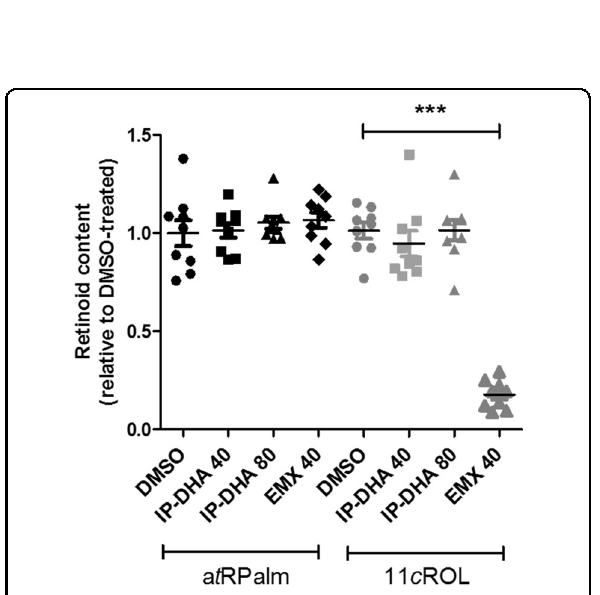
Fig. 8 Emixustat, but not IP-DHA, inhibits RPE65 isomerase activity. HEK-LR cells stably expressing LRAT-CFP and RPE65-GFP were plated in T25 fl asks at 10 5 cells/ml and grown for 24 h before DMSO (CTL), IP-DHA (40 and 80 µM), or EMX (40 µM) was added. Cells were cultured for 24 h and incubated with 10 µM a t ROL for the last 24 h. Normal-phase HPLC was used to analyze the retinoid extracts from the cells. Data are presented as the mean ± SEM. *** n = 3 independent experiments with each treatment performed in triplicate. One-way ANOVA Kruskal – Wallis test with Dunn ’ s multiple comparison test: p < 0.001 EMX vs. DMSO. Black dots represent LRAT activity, gray dots represent RPE65 isomerase